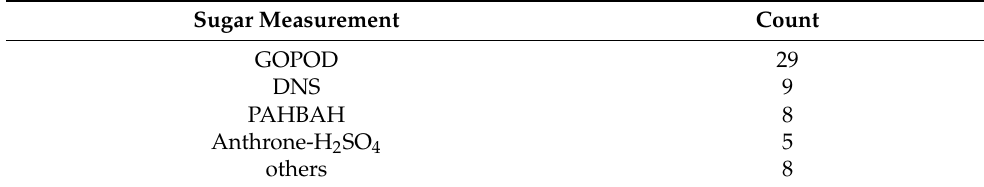
Table 4. Sugar measurements for selected papers. Sugar Measurement Count GOPOD 29 DNS